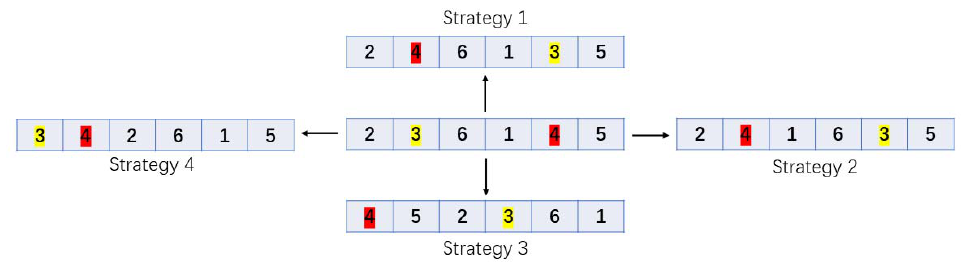
Figure 3. Schematic diagram of the mutation strategy.